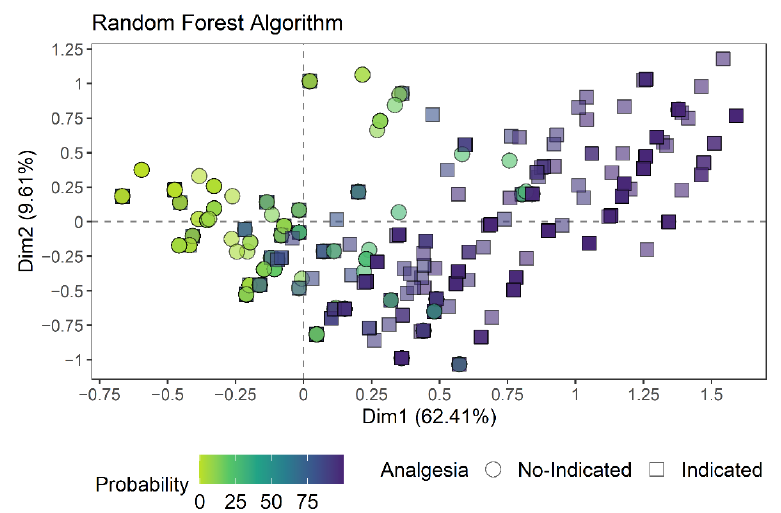
Figure 4. Two-dimensional perceptual map of the multiple correspondence analysis showing the dispersion of expert opinion of no-indication or indication to apply analgesia and probability of sheep needing analgesia according to the random forest algorithm (Circles and squares indicate each evaluation; the greater the number of dark squares and the greater the number of light circles, the greater the accuracy of the